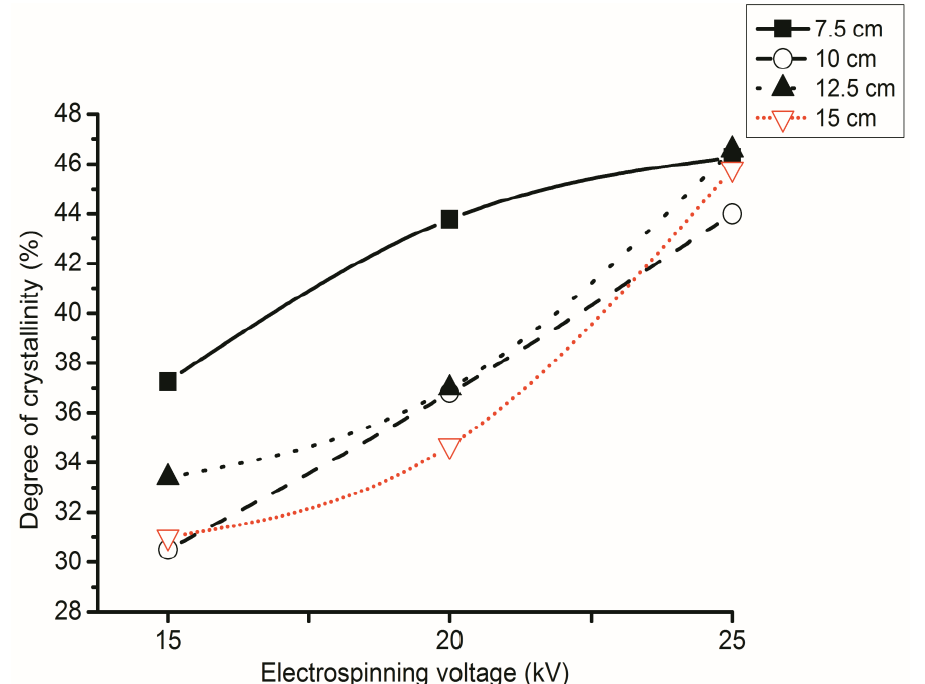
Figure 7. Effect of voltage on the degree of crystallinity of fibers electrospun from 8 wt% solution concentration at different